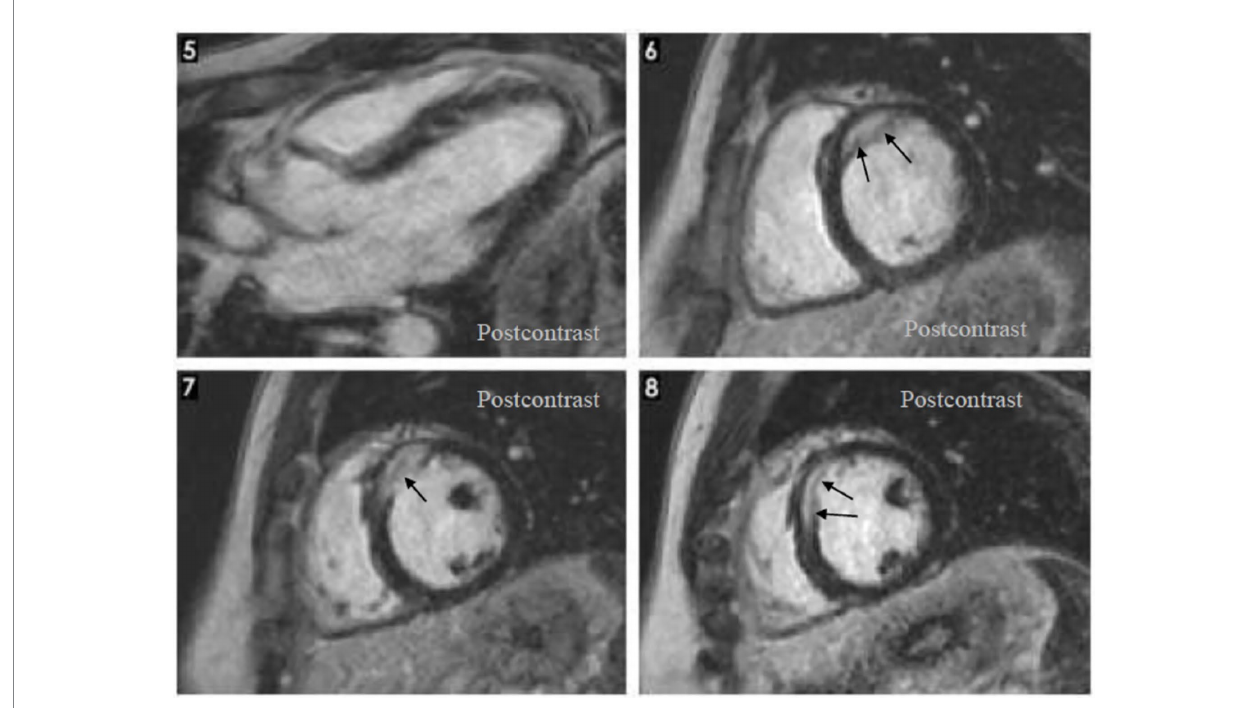
FIGURE 3 Cardiac magnetic resonance: Hypertrophy localized at the base of the septum, T2 focal edema at the base of the septum, late gadolinium enhancement: homogenous late uptake of gadolinium in the